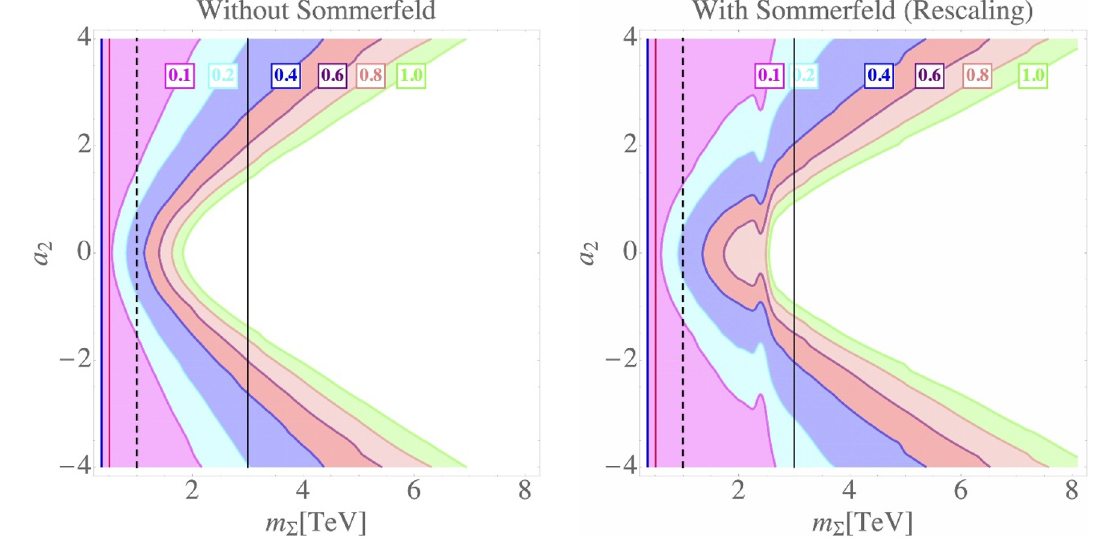
Figure 6 . Left panel: the parameter space that can explain current DM relic density without including the Sommerfeld effect. Numbers in boxes on the curves correspond to the fractions of Σ SM contribution to the total DM relic density measured by Planck [4]. The blue (red) vertical band corresponds to the exclusion limit obtained in figure 5 with the inclusion of 30% systematic uncertainties for higher luminosity LHC with = 300 fb − 1 and 3000 fb − 1 , and the black dashed L and solid lines correspond to the 5 σ discovery benchmark points we obtain in table 1 for a future ≥ 100 TeV pp collider with = 30 ab − 1 . Right panel: same as the left but with the Sommerfeld effect L